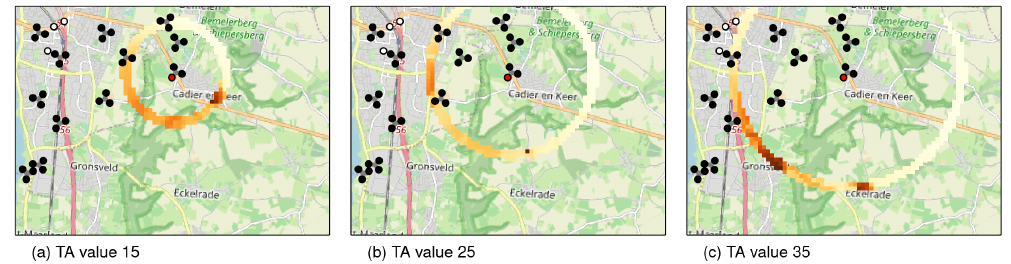
Figure 11: Updated location posterior with Timing